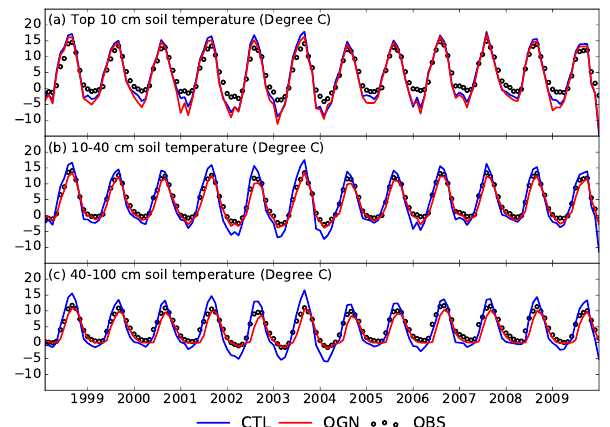
Figure 4. Observed and Noah-MP-simulated monthly soil temper- ature for BERMS SK-OAS site at a depth of (a) top 10cm, (b) 10– 40cm, and (c)